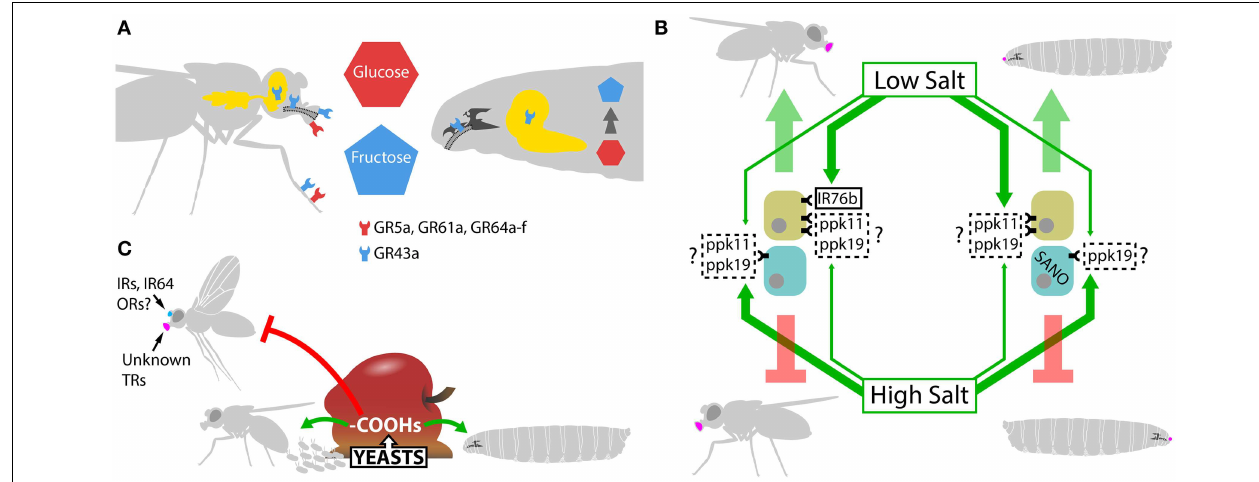
least in adults, IRs, ORs, and the H + sensor IR64a in the olfactory system and unknown taste receptors (TR) are responsible for carboxylic acid perception. (C) Salt detection in adult and Drosophila larva. Both adults and larvae are attracted to low salt and repulsed by high-salt solutions. In adults, IR76b is a Na + -permeable channel essential for low-salt responses; plus, ppk11 and ppk19 might be involved in the attraction toward low-salt solutions. IR76b is expressed in a subset of GRNs, which respond strongly to low salt, while a different subpopulation of GRNs is strongly activated by high-salt solutions. In larvae, ppk11 and ppk19 are most likely the taste receptors responsible for attractive responses to low-salt concentrations. The chemoreceptors for high-salt solutions remain unknown, but ppk11 and ppk19 may contribute to the responses. At least in larvae, the cytoplasmic protein SANO expressed in bitter neurons is essential for the behavioral aversion to high-salt concentrations. The thick green arrows indicate strong activation while the thin ones, weak activation. In the boxes, a full-lined frame indicates that the protein is a bona fide chemoreceptor, while a dotted-line means that there is still no clear demonstration of the protein’s role as